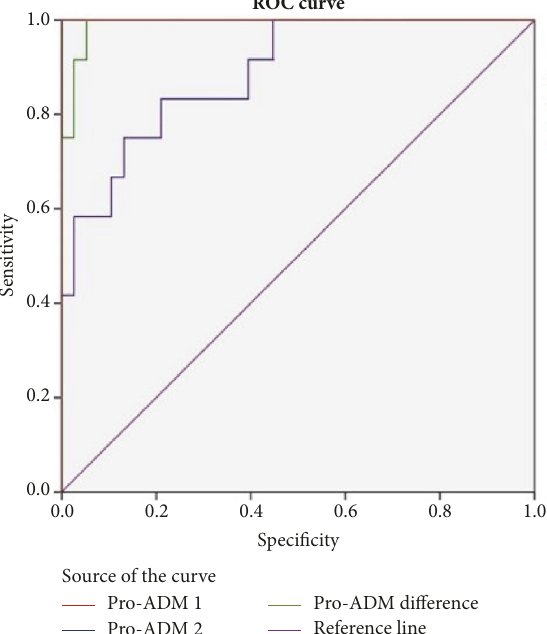
Figure 2: ROC curve for Pro-ADM in predicting the survival in the study population.